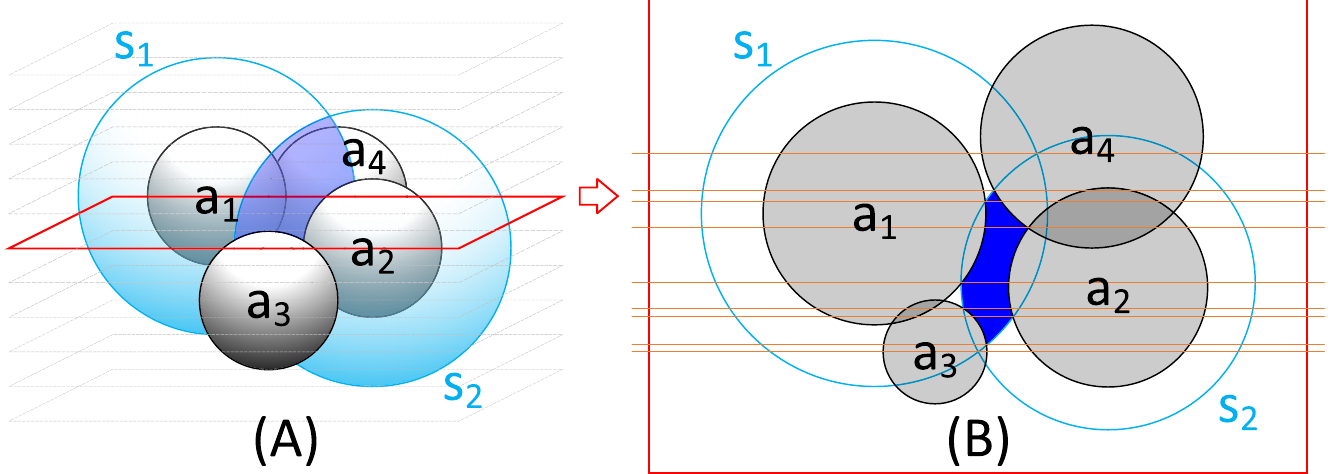
Fig 1. Illustration of the common solvent accessible volume of two atoms a 1 and a 2 in (A), and its cross-sectional shape and sweep lines in (B).